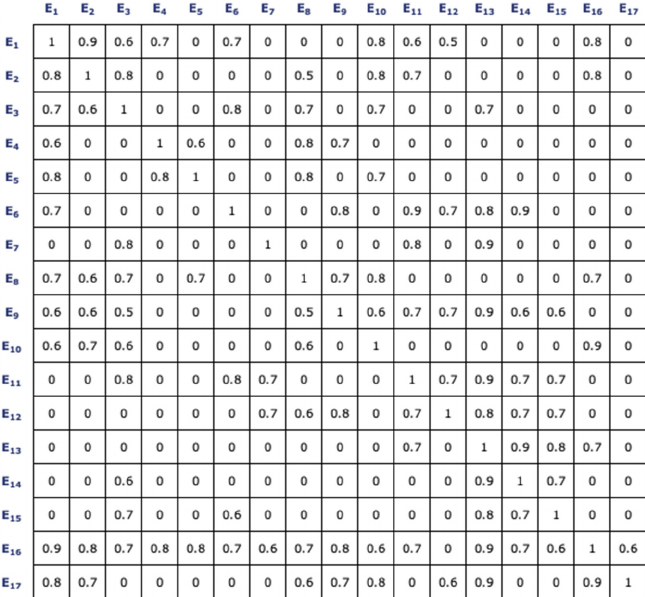
Figure A4. Cumulative effects matrix. Figure A5. Forgotten Effects matrix. References 1.